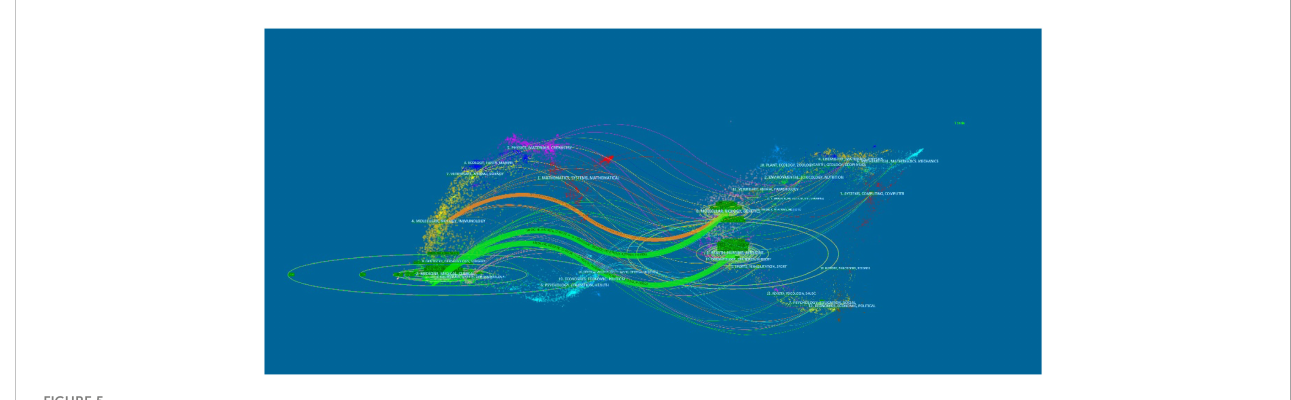
FIGURE 5 The dual-map overlay of journals that contributed to publications.